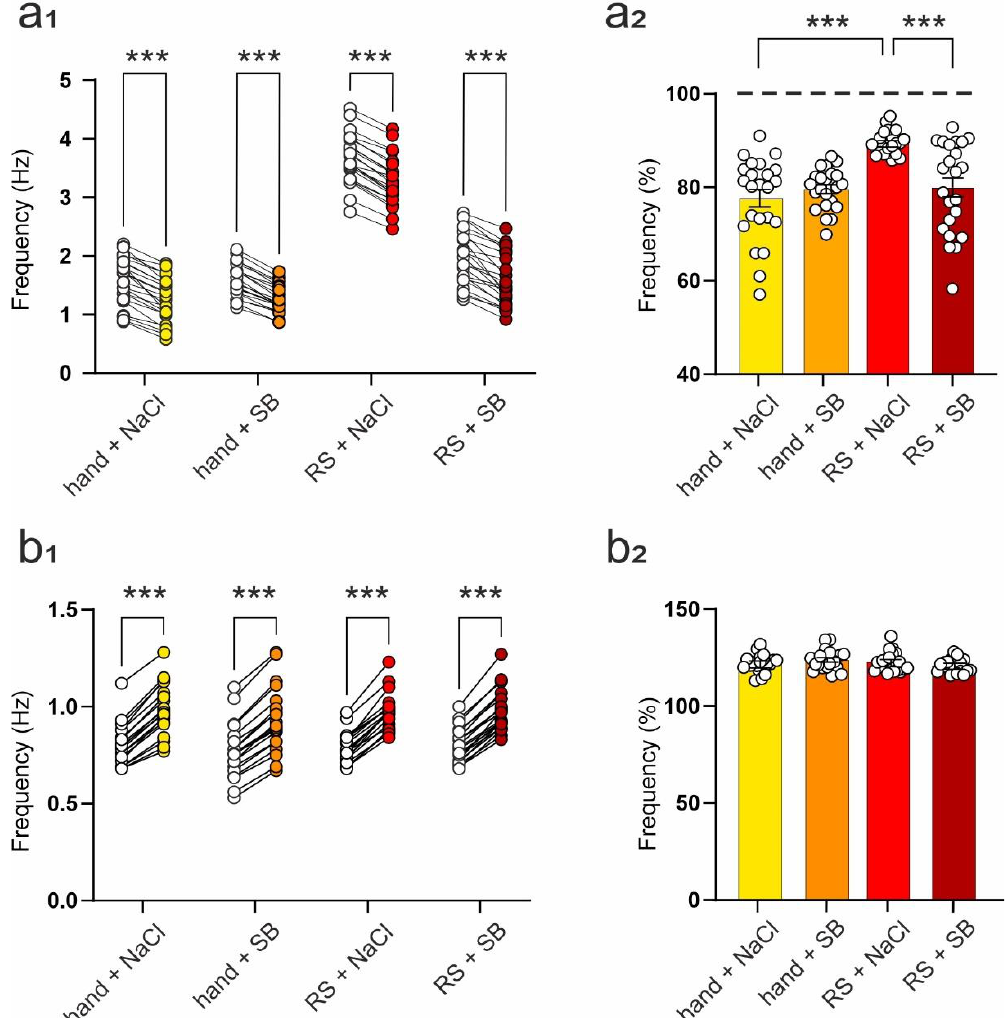
Figure 4. The influence of SB 269970 administration on restraint stress-induced changes in sEPSC ( a 1 , a 2 ) and sIPSC frequency ( b 1 , b 2 ) and the effects of 5-HT7R activation. ( a 1 ) The effects of 5-HT7R activation on the frequency of sEPSCs recorded from neurons originating from each group. For each cell, shown are mean sEPSC frequency values before (open circles) and after (filled circles) addition of 5-CT to the ACSF. *** p < 0.001; ( a 2 ) The effect of 5-HT7R activation on the sEPSC frequency (mean ± SEM) shown as a percentage of basal sEPSC frequency (before 5-CT addition). Hand + NaCl vs. RS + NaCl: *** p < 0.001; RS + NaCl vs. RS + SB: *** p < 0.001; ( b 1 ) The effects of 5-HT7R activation on the frequency of sIPSCs recorded from neurons originating from each group. For each cell, shown are mean sIPSC frequency values before (open circles) and after (filled circles) addition of 5-CT to the ACSF. *** p < 0.001; ( b 2 ) The effect of 5-HT7R activation on the sIPSC frequency (mean ± SEM) shown as a percentage of basal sEPSC frequency; p > 0.05. In each graph, circles represent individual cells. Table 7. Effects of 5-HT 7 receptor activation on parameters characterizing sEPSCs in DRN neurons from rats receiving restraint and SB 269970 (mean ± SEM).